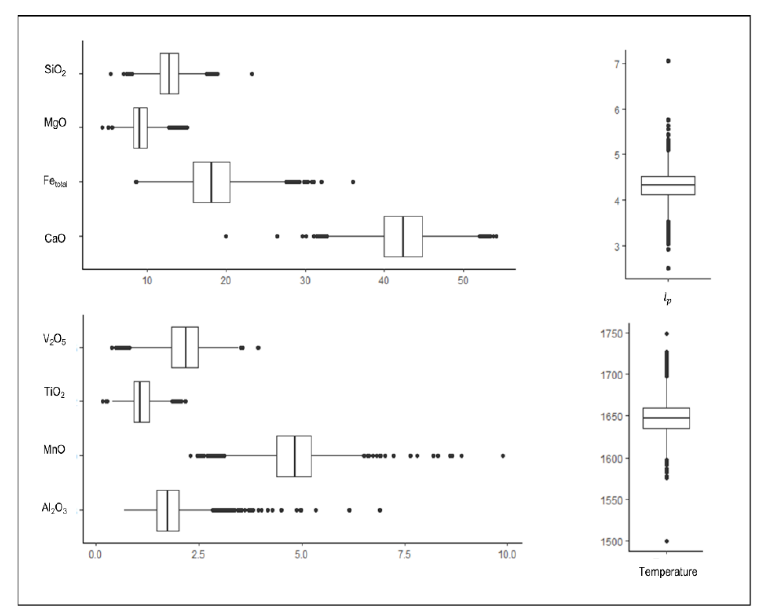
Figure 4. Box plots of all features and the response variable for plant I data.